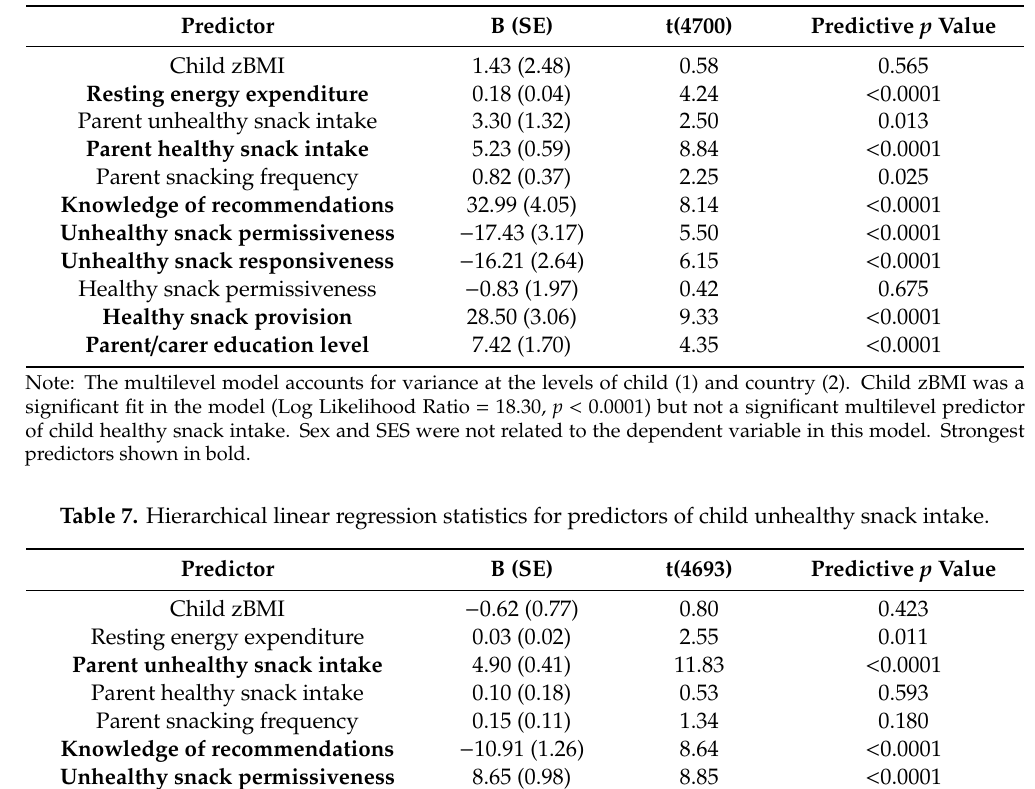
Table 6. Hierarchical linear regression statistics for predictors of child healthy snack intake.